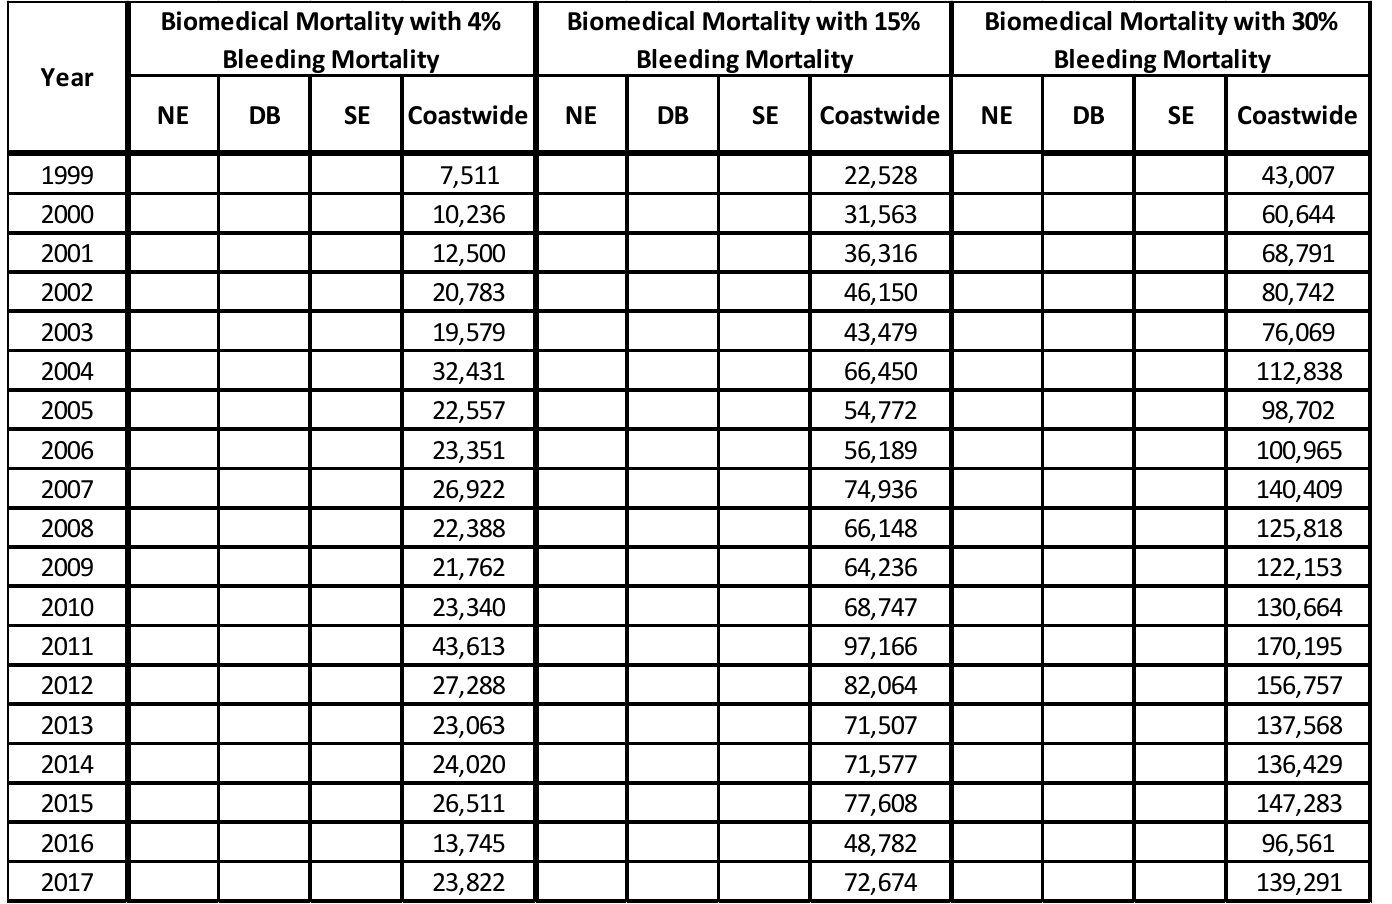
Table 26. Regional (NE: Northeast, DB: Delaware Bay, SE: Southeast; CONFIDENTIAL data removed) and coastwide estimates of biomedical mortality (numbers of crabs) using bleeding mortalities of 4%, 15%, and 30%. Delaware Bay estimates include all crabs caught from New Jersey through Virginia, not only those of Delaware Bay